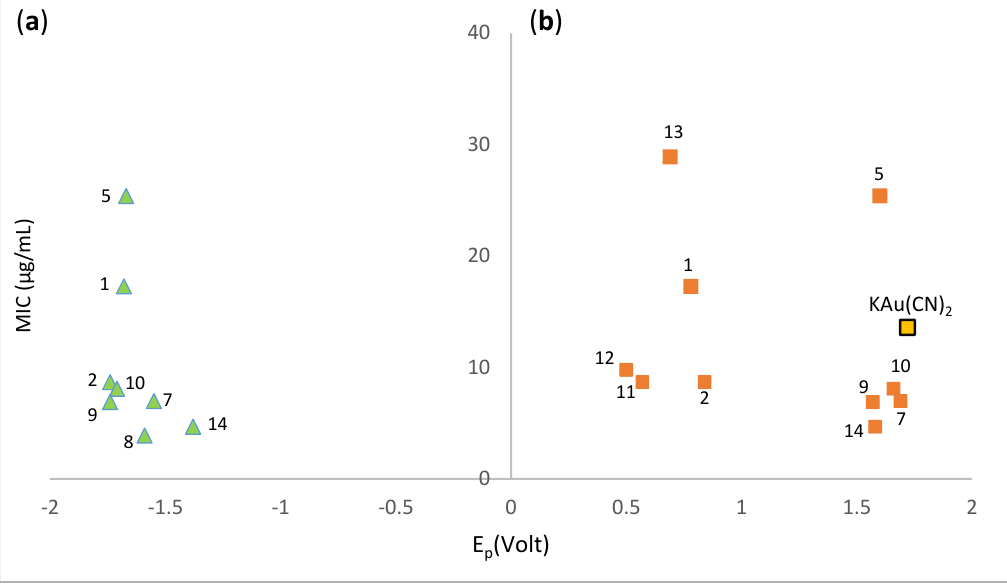
Figure 4. Relationship between the MIC values for P. aeruginosa 477 and the cathodic ( a ) and anodic ( b ) redox potentials for the complexes.